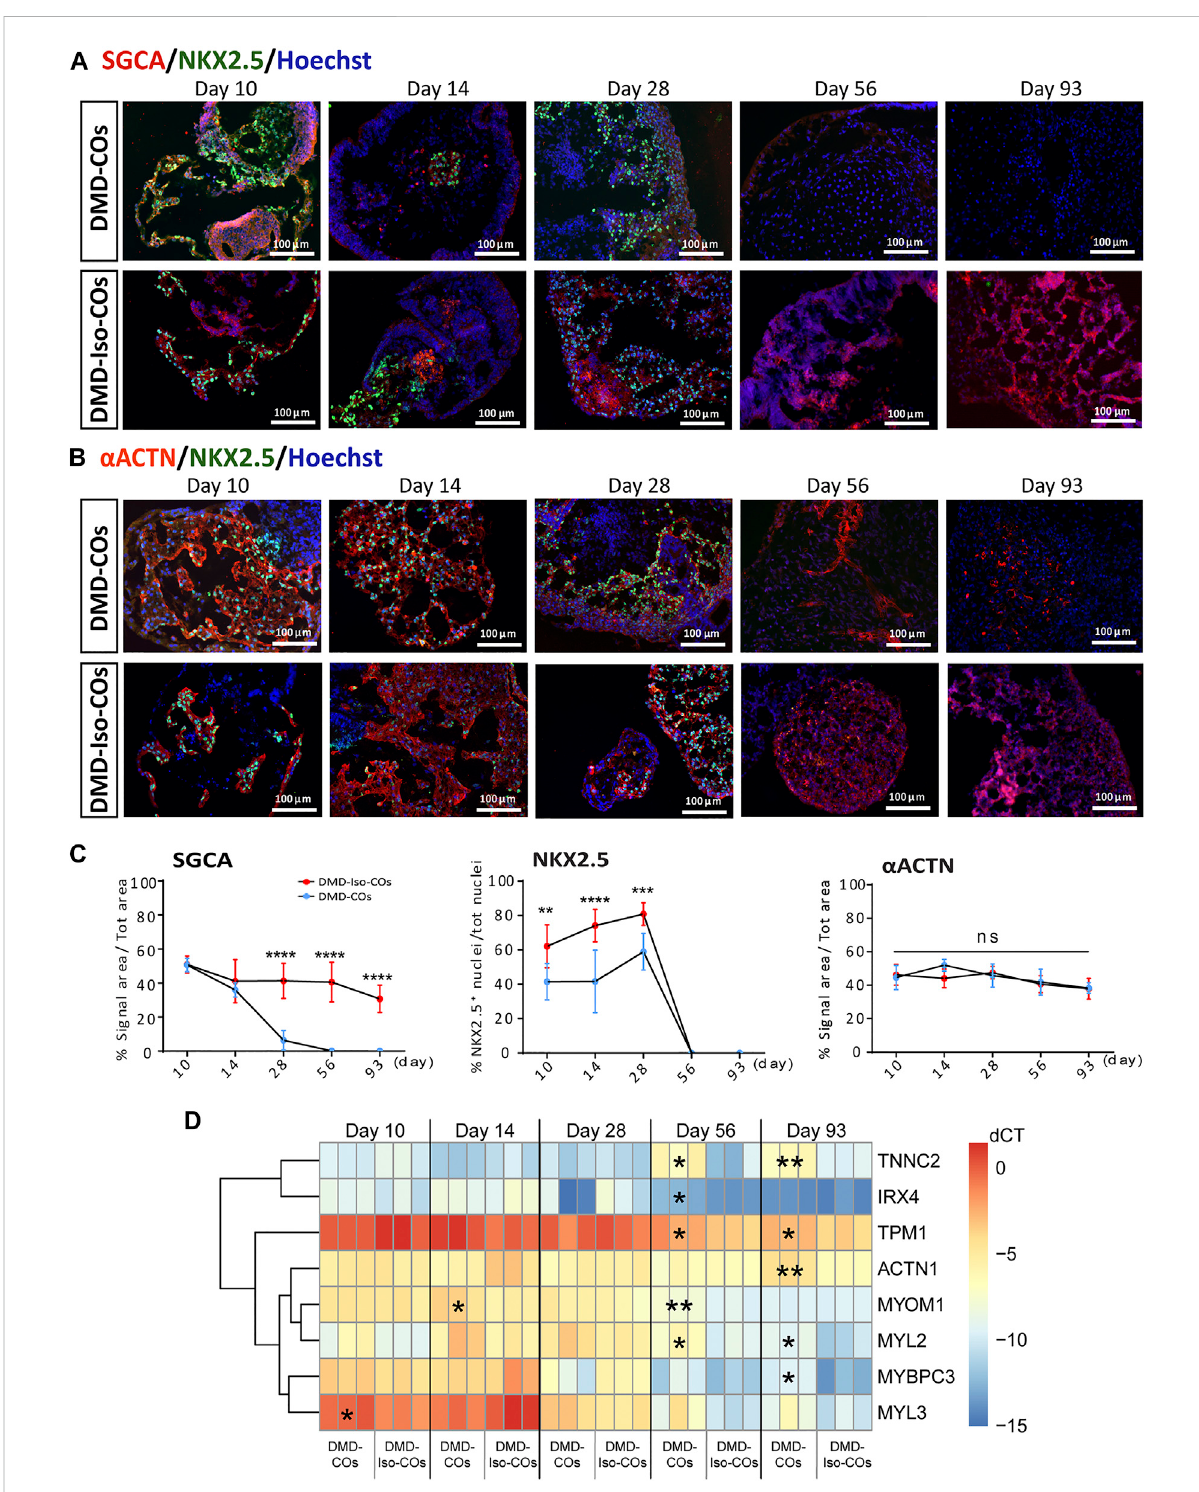
FIGURE 3 Assessment of cardiac differentiation and contractile proteins development in DMD-COs and DMD-Iso-COs over 93 days of dynamic culture. Representative immuno fl uorescence images for: (A) α -sarcoglycan (SCGA)/NKX2.5, and (B) sarcomeric α -actinin ( α ACTN)/NKX2.5 co-staining in DMD-COs and DMD-Iso-COs, respectively. Nuclei were counterstained with Hoechst. Data are representative of three independent experiments ( n = 3). (Magni fi cation: ×20). (C) Quanti fi cation of the immuno fl uorescence images for: SGCA, NKX2.5 and α ACTN on day 10, 14 28, 56 and 93. Data shown are mean ± s.d. ( n = 4, two-way ANOVA with Sidak ’ s multiple comparisons: * p < 0.05, ** p < 0.01, *** p < 0.001, **** p < 0.0001. (D) RT- qPCR analysis of representative gene markers expression for cardiac contractility in DMD-COs and DMD-Iso-COs. Data shown are mean ± s.d. ( n = 3, each pooled from ~10 organoids). Statistical analyses were performed by two-way ANOVA with Tukey ’ s multiple comparisons: * p < 0.05, ** p <